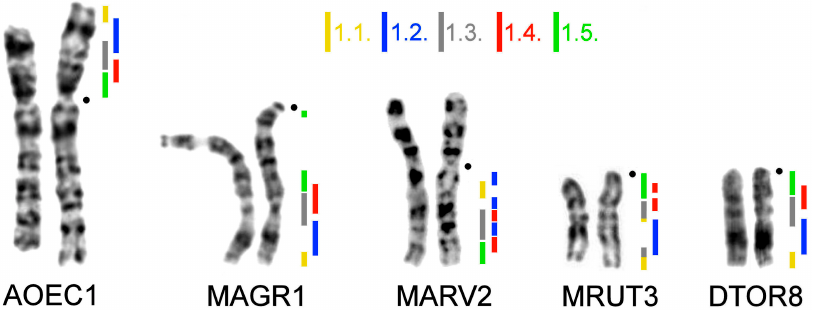
Figure 1. Localization of A. oeconomus region-specific probes onto chromosomes of members of the Arvicolinae. AOEC— A. oeconomus , MAGR— M. agrestis ; MARV— M. arvalis ; DTOR— D. torquatus . Colored lines and numerals correspond to individual microdissection-derived painting probes.